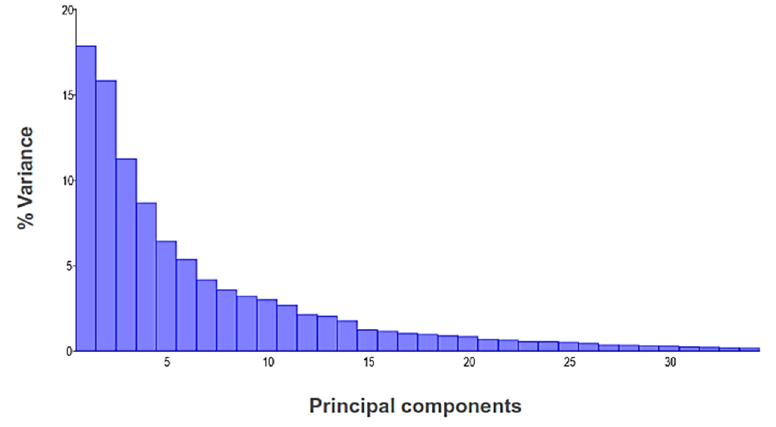
Figure 3. Eigenvalue showing the relative percentage of principal components among populations of Apis mellifera .